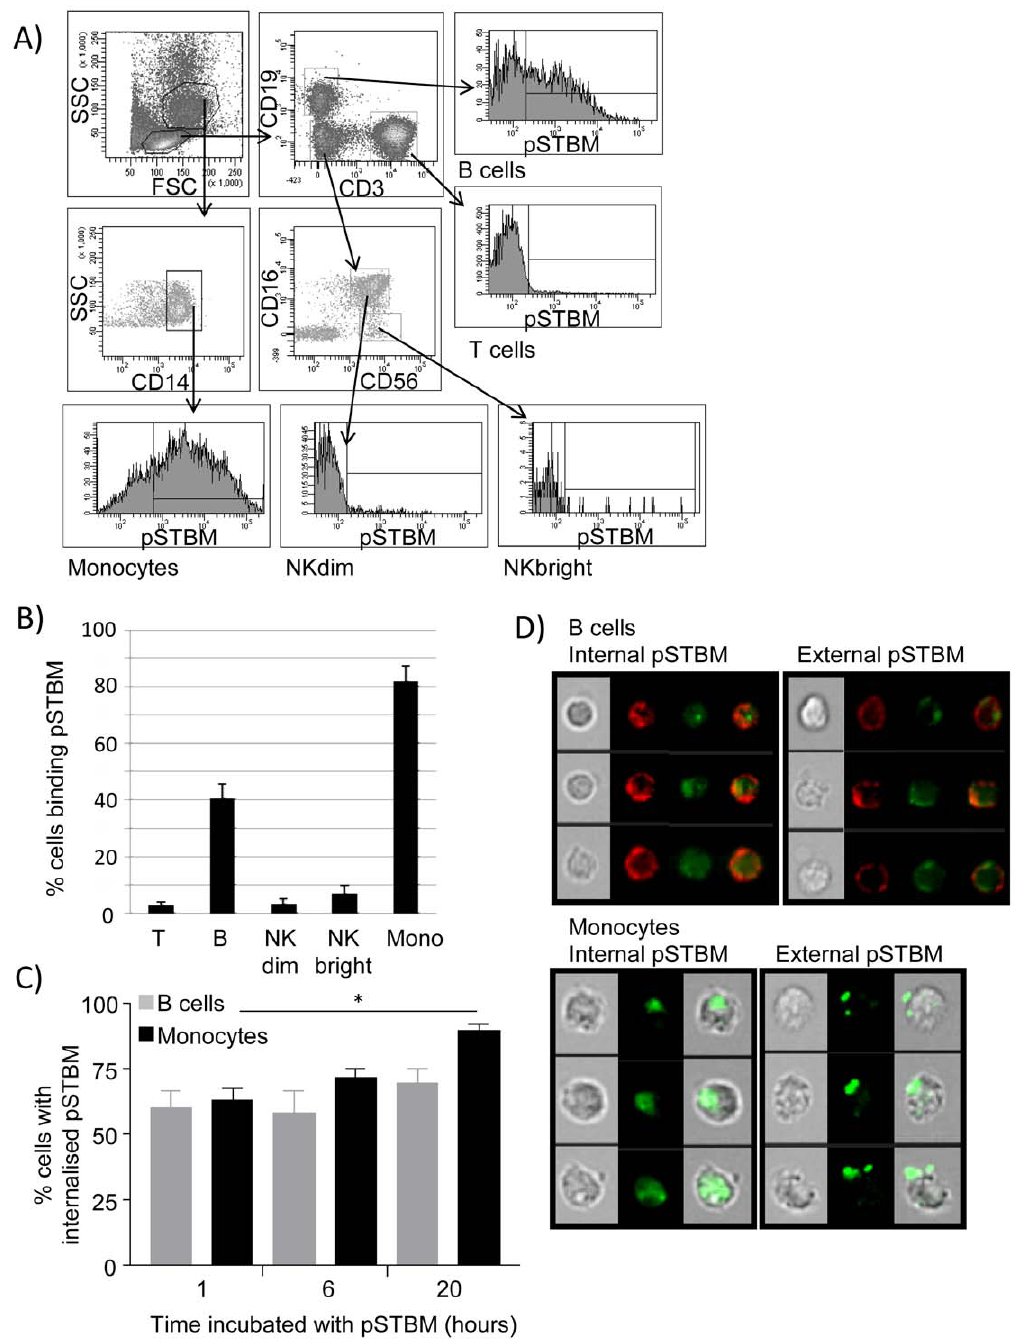
Figure 4. pSTBM bind to monocytes and B cells. 10 6 PBMC from normal pregnant women were incubated with 50 m g/ml pSTBM for one hour at 37 u C. Cells were then washed in PBS and stained for antibodies towards CD3, CD14, CD19, CD56 and CD19, and the proportion of cells with bound pSTBM identified with the trophoblast specific marker NDOG-2. Gates were set by staining PBMC with all six antibodies without the addition of pSTBM. NDOG-2 staining of cell populations was also compared to an isotype control (representative staining profile shown in A). Binding of pSTBM to cell populations shown in B (n=3; mean + / 2 S.E.M.). C) Image stream analysis of B cell (grey bars) and monocyte (black bars) internalisation of pSTBM (labelled with BODIPY FL Maleimide) with IDEAS software (n=3; mean + / 2 S.E.M.; *=p , 0.05). D) Representative images of cells with